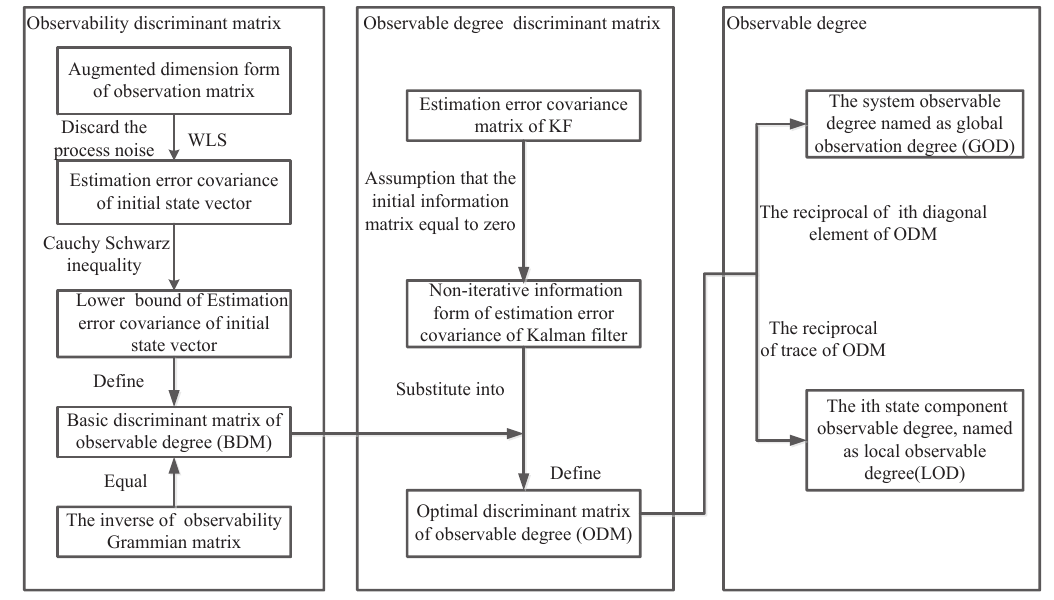
Figure 1. The process of